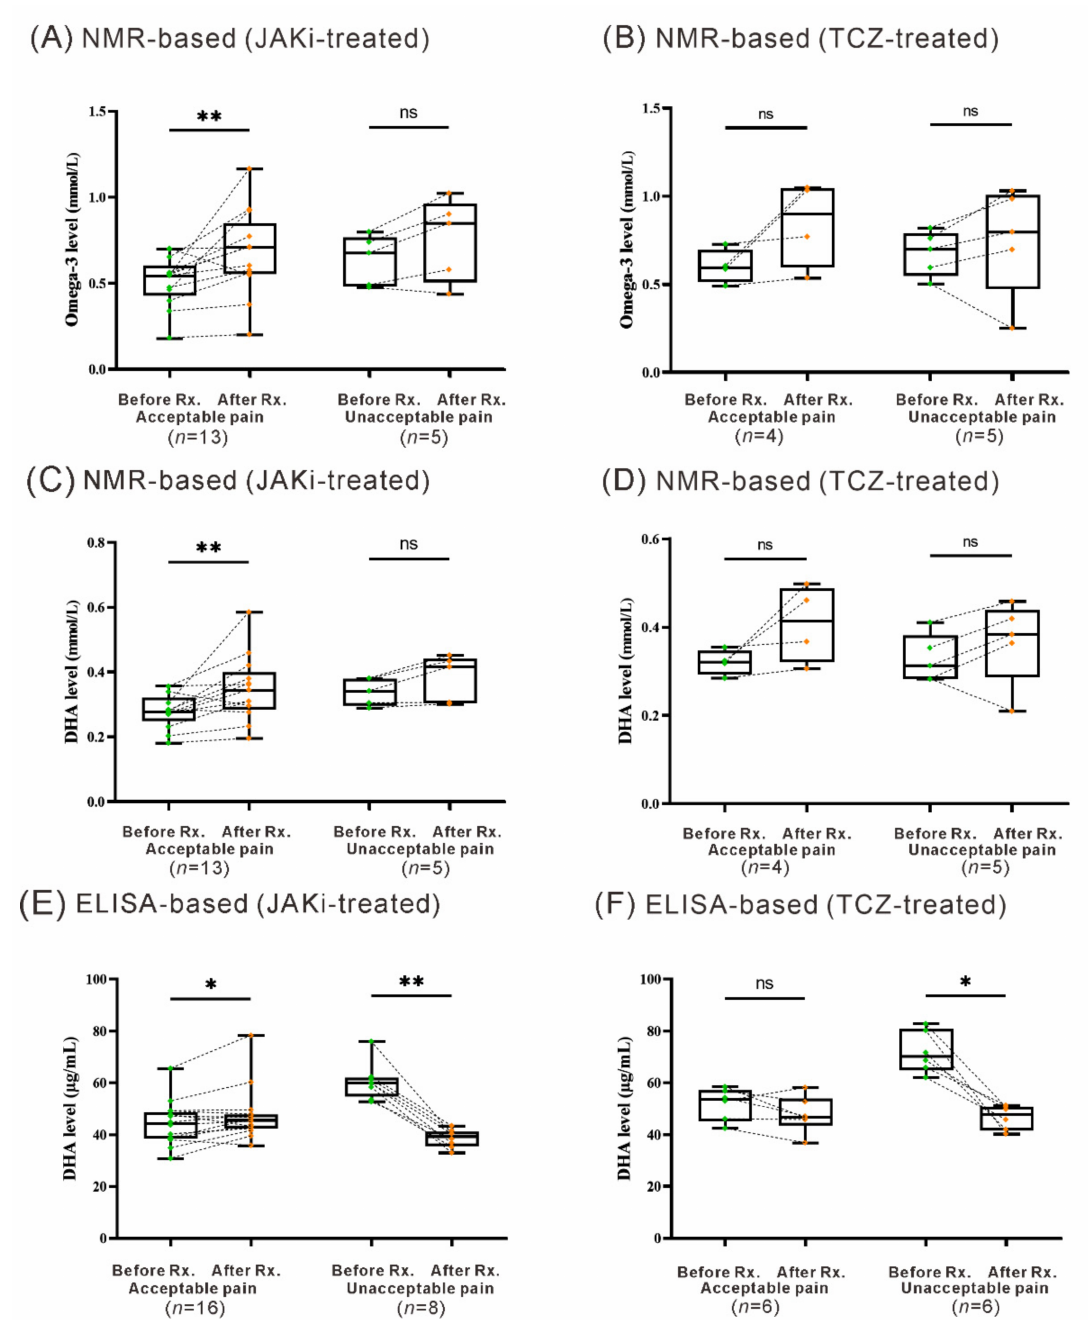
Figure 3. Change of serum levels of omega-3 PUFAs and DHA in JAKi-treated and TCZ-treated patients with acceptable pain or unacceptable pain assessed at week 24. The comparison of serum levels of omega-3 determined by NMR-based lipid/metabolomics in ( A ) JAKi-treated or ( B ) TCZ-treated patients with acceptable pain or unacceptable pain assessed at week 24. The comparison of serum levels of DHA determined by NMR-based lipid/metabolomics in ( C ) JAKi-treated or ( D ) TCZ-treated patients with acceptable pain or unacceptable pain assessed at week 24. The comparison of serum DHA levels determined by ELISA in ( E ) JAKi-treated and ( F ) TCZ-treated patients with acceptable pain or unacceptable pain assessed at week 24. Data are presented as box-plot diagrams, with the box encompassing the 25th percentile (lower bar) to the 75th percentile (upper bar). The horizontal line within the box indicates median value respectively for each group. * p < 0.05, ** p < 0.005, was determined by the Wilcoxon signed rank test. NMR-based: 1 H-nuclear magnetic resonance-based lipid/metabolomics; JAKi: Janus kinase inhibitors; TCZ: tocilizumab; PUFAs: polyunsaturated fatty acids; DHA: docosahexaenoic acid; ns: no